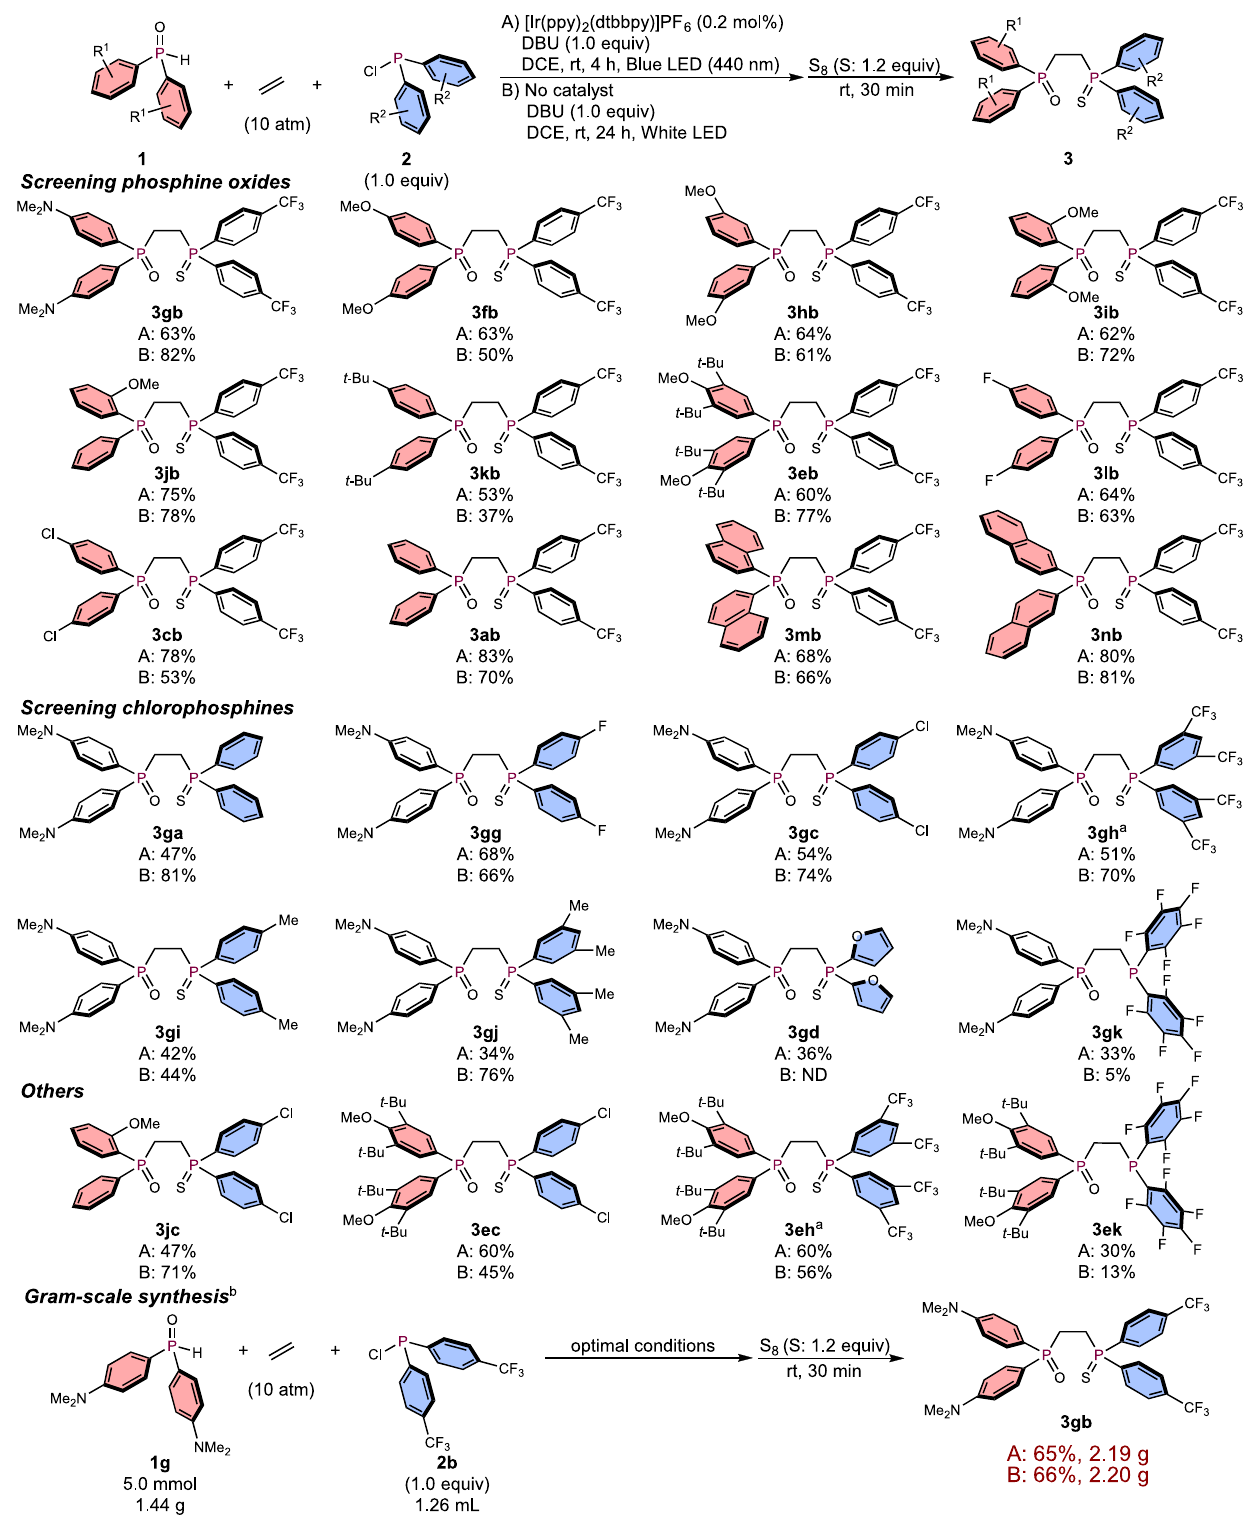
Fig.4|ScopeofunsymmetricDPPEderivatives. AswithFig.3. a Sulfur(2.4equiv)wasadded,andthereactionmixturewasstirredfor24h. b FourwhiteLEDswasusedfor condition